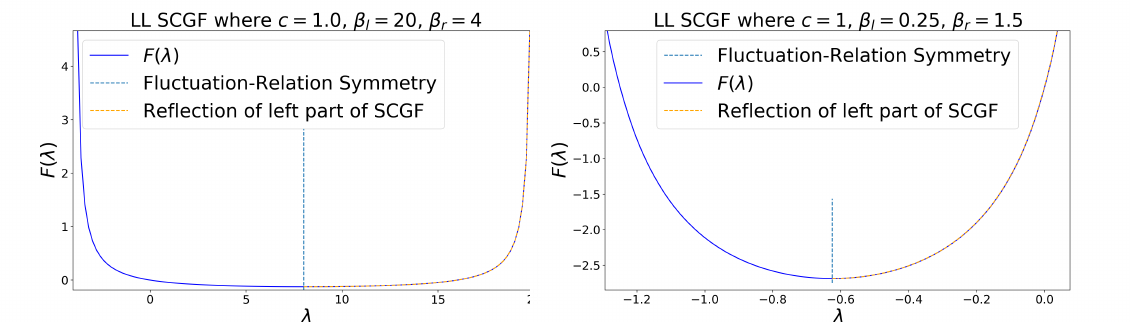
Figure 4: Energy flow SCGF for the Lieb-Liniger model using equation (25). Both plots use an interaction strength of c = 1. In (a) the parameters used are β β = 4 and in (b) β = 0.25, β = 1.5. In both cases a dotted line is plotted for the r l r − β ) / 2. Both plots also indicate the symmetry by expected symmetry point at ( β l r reflecting the left-hand side of the plot onto the right-hand side of the plot.